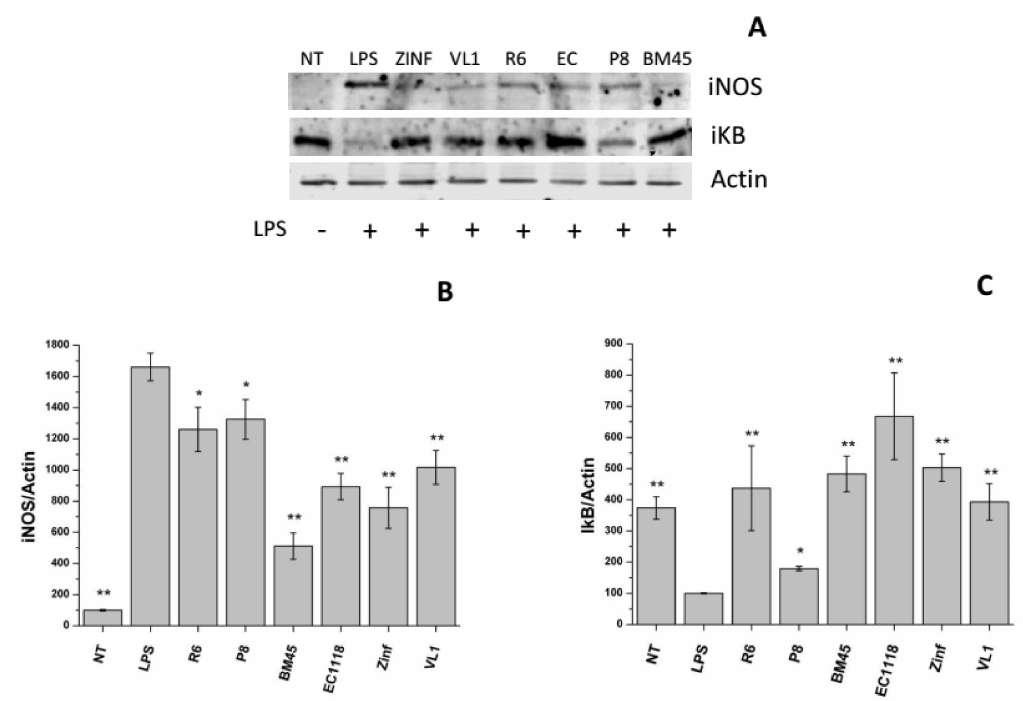
Figure 4. Western blot analysis of iNOS and I κ B from RAW 264.7 cells. ( A ) Western blot analysis of the cell lysates detected by anti-I κ B and anti-iNOS monoclonal antibodies. Actin was used as a loading control. The intensity of each band was measured by using a Molecular Imaging Station from Kodak. ( B , C ) Relative protein level from Western Blot data. ( B ) iNOS expression level; ( C ) I κ B expression level. Intensity of each signal was measured and normalized on the actin signal. Results are the mean ( ± SD) of three different experiments performed in duplicate. Statistical analysis was performed for each sample vs. the LPS values (* p < 0.05; ** p <